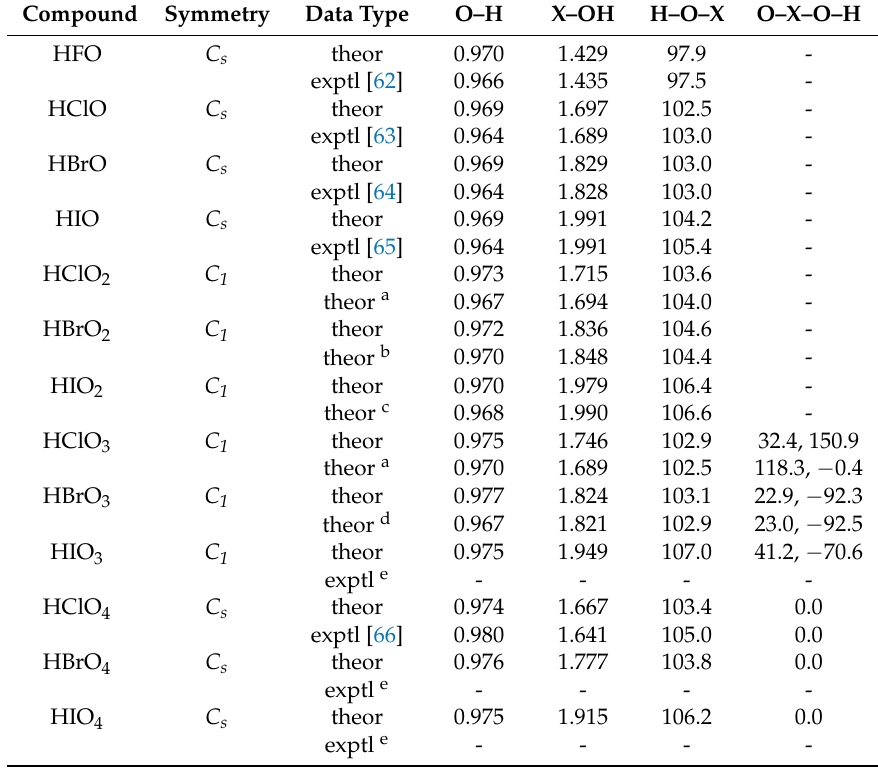
Table 1. RI-MP2/aug-cc-pVTZ (theor) and experimental (exptl) geometries of halogen oxoacids (in angstroms and